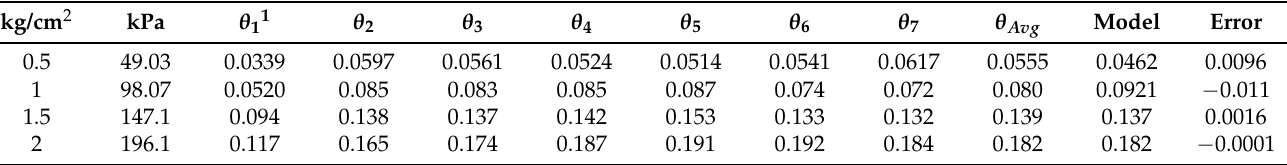
Table 1. Comparison between measured angles and mathematical model’s results (Radians).